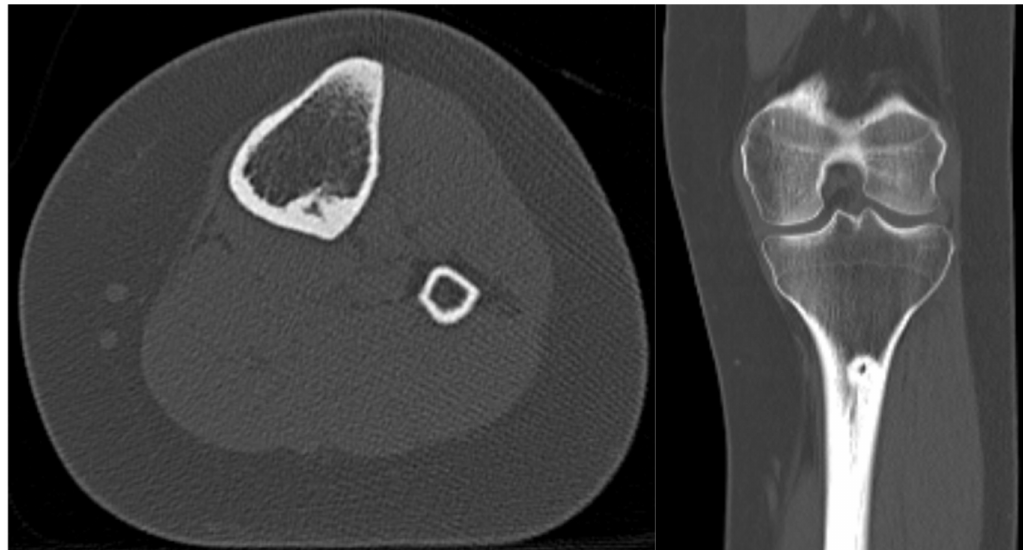
Figure 4. Pre-treatment axial and coronal CT of a leg confirming an osteoid osteoma of the posterior lateral proximal tibia. The patient underwent a single treatment with CT-guided microwave ablation. At the two-week post-treatment visit, the patient reported complete pain relief with a full MSTS lower extremity functional outcome score of 30. She was not taking any pain medications.